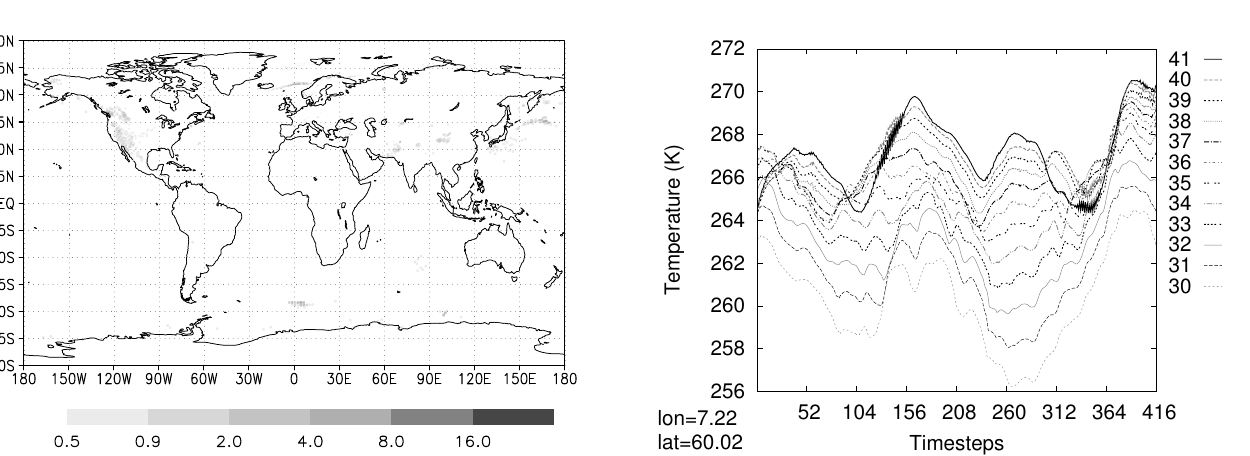
Fig. 6. The amplitude of 2∆ t temperature oscillations on the lowest model level (in Kelvin) after 96 hour forecast computed according to Equation 9 for the model run with the fibrillation amplification test of the large scale precipitation scheme.